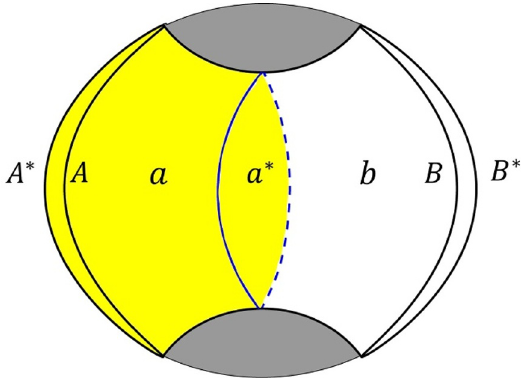
Figure 15 . (a) The entropy associated to M 1 and L M curves that has smaller entropy. Note that the RT surface becomes L M take r h = 10 , l = 1 , G N = 1 . 5 and c 0 = 5 c . The reflected entropy is the solid curve which saturates when r 0 ≈ 6 . h